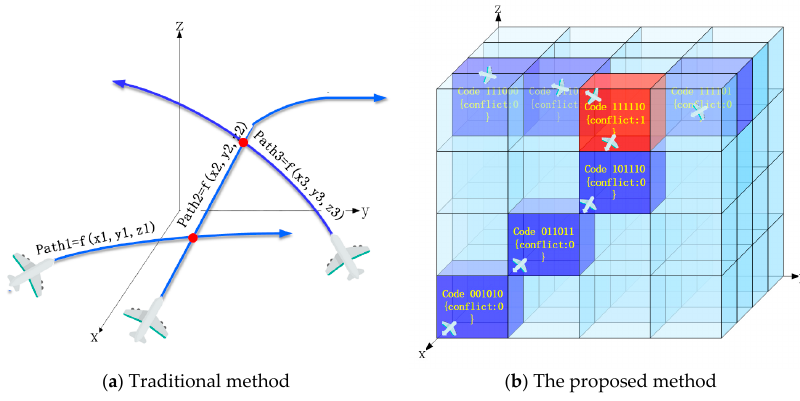
Figure 1. Schematic diagram of di ff erent methods.